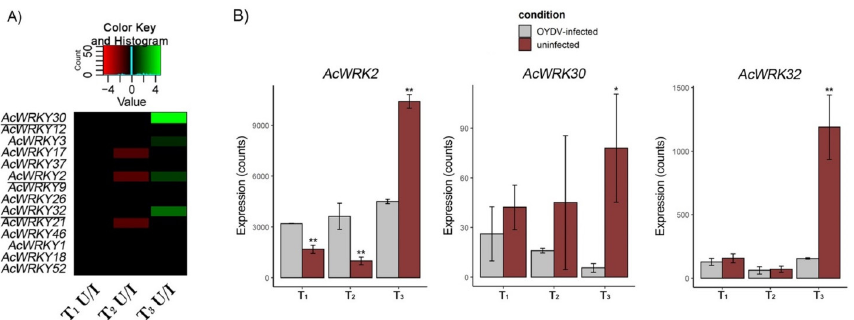
Figure 4. Expression levels of AcWRKY genes isolated in onion bulb at the beginning of dormancy (T 1 ), late dormancy (T 2 ), and the dormancy release (T 3 ). ( A ) Heatmap developed using log2 FC values (by Deseq2) of AcWRKYs for uninfected (U)/OYDV-infected (I) bulbs compared at each time; AcWRKYs showing significant differences by RNASeq ( p < 0.05; log2 FC > 1) and qPCR between the two conditions during dormancy release (T 3 ) were underlined. ( B ) Normalized RNA-Seq counts of AcWRKY2, 30 , and 32 at each sampling time, detected in uninfected (red) and OYDV-infected (gray) samples. ** p < 0.05, * p < 0.1 (between infected and uninfected bulbs).